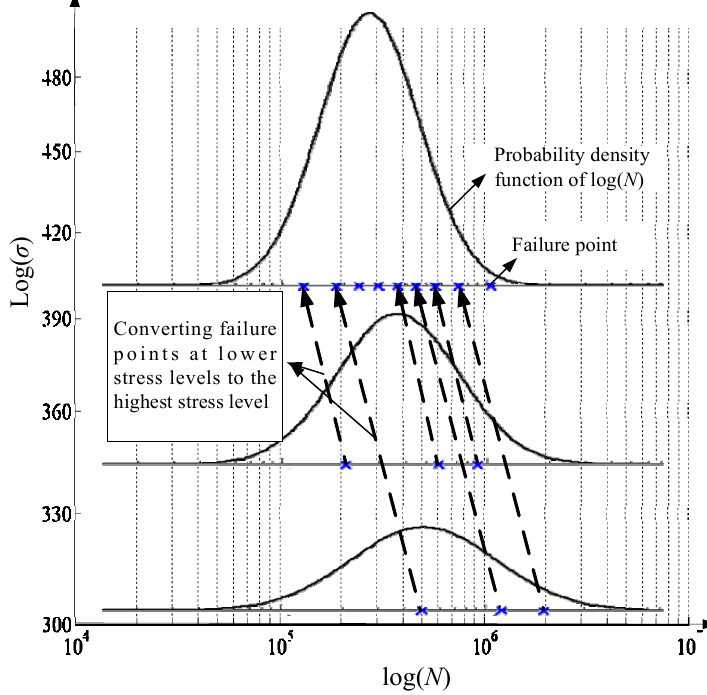
Figure 2. Fatigue life